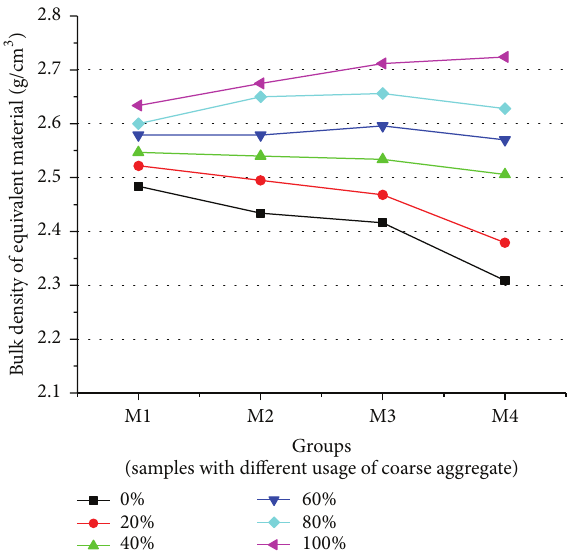
Figure 7: Bulk density of the equivalent material versus coarse aggregate